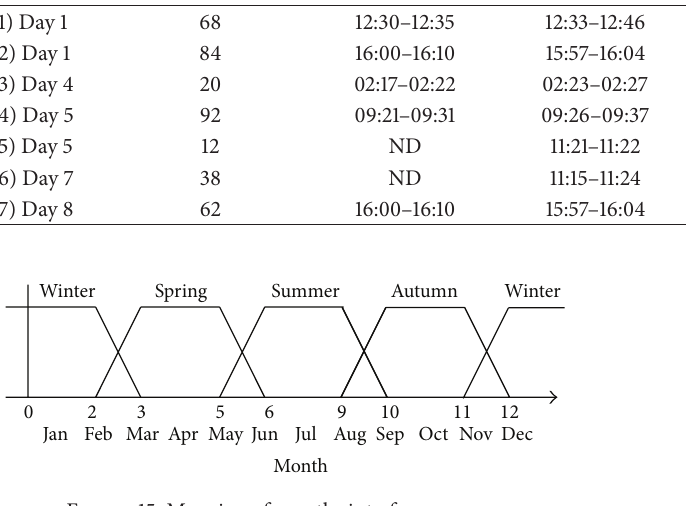
Figure 15: Mapping of months into four seasons.